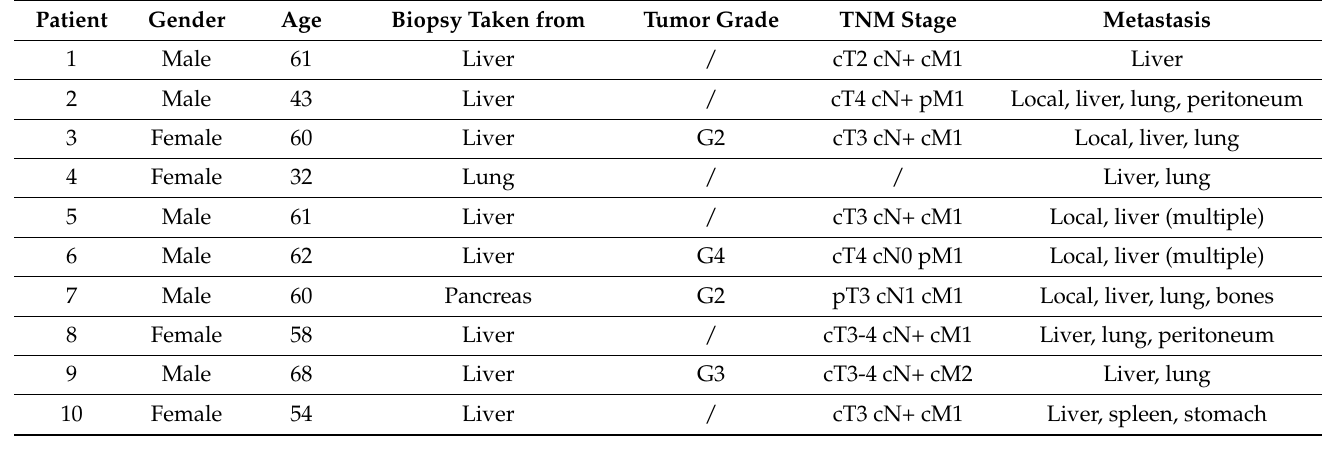
Table 1. Patient data. Patient cohort comprising 10 patients with advanced-stage PDAC.